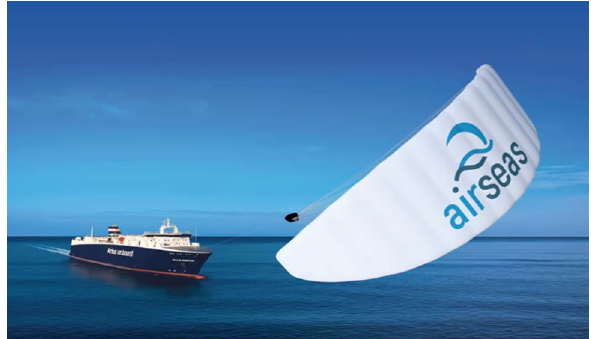
Fig. 7 An automated kite Seawing built on Ville de Bordeaux (www. burea uveri tas. com)